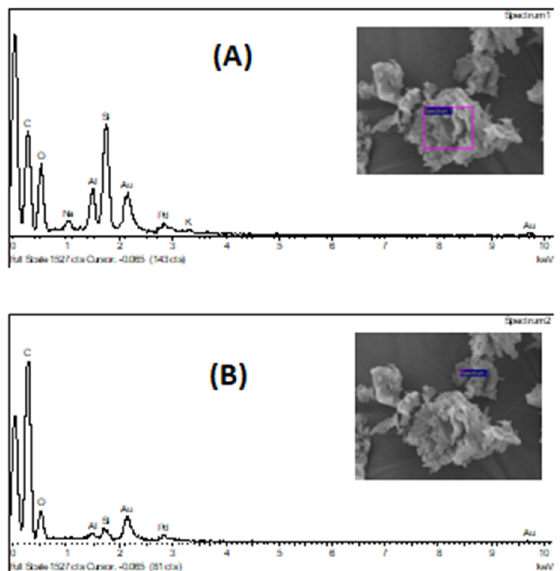
Figure 13. EDS spectra and respective SEM image of: ( A ) solid sample collected before the syngas production test at 300 ◦ C with 4% of z. HY catalyst and ( B ) solid sample collected after the syngas production test at 300 ◦ C with 4%g of z. HY catalyst.